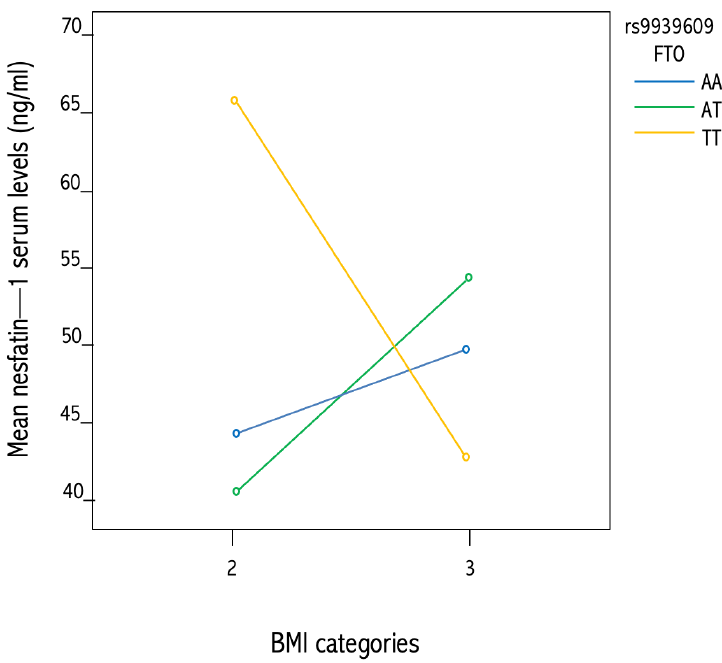
Figure 4. Interaction of FTO × BMI on nesfatin-1 plasma